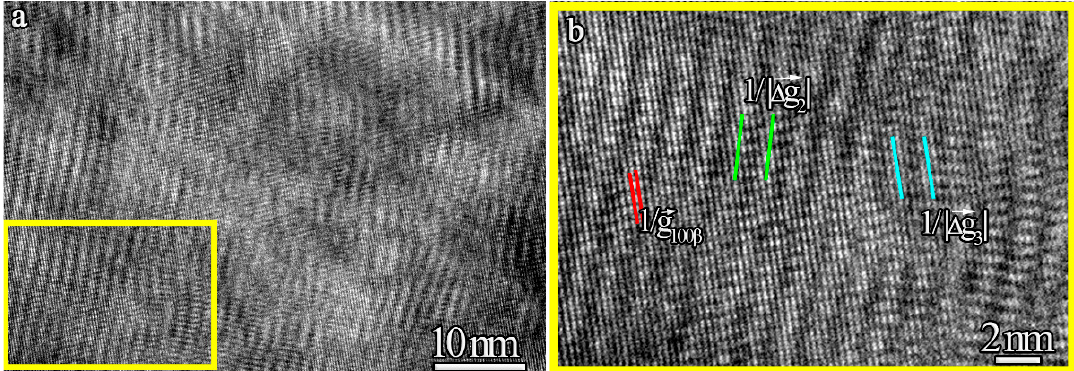
Figure 3. ( a ) HRTEM image of a part of the Cu-Pd36 sample within the block of α -phase subgrains, ( b ) enlarged fragment containing interference bands with a period equal to the β -phase crystal lattice parameter 1 (cid:3627)(cid:3416) , and moiré patterns with the periods (cid:3627)(cid:3416) and (cid:3627)(cid:3416) (2 and 3). (cid:3627)𝑔⃗ (cid:3627) 𝑔(cid:4652)(cid:4652)(cid:4652)(cid:4652)(cid:4652)⃗ (cid:3627) 𝑔(cid:4652)(cid:4652)(cid:4652)(cid:4652)(cid:4652)⃗ (cid:2869)(cid:2868)(cid:2868) (cid:2870) (cid:2871) While there are strictly periodic interference lines (interference of the 000 and 100 β 1 beams) with the period |(cid:3415) ( 𝑔⃗ is the reflection vector from index planes) corre- |𝑔⃗ (cid:2869)(cid:2868)(cid:2868) sponding to the β -phase structure parameters, breaks of moiré patterns with the periods 1 𝑃𝑀1 = 1 (cid:3627)(cid:3416) and 𝑃𝑀2 = (cid:3627)(cid:3416) are observed as a result of double (cid:3627)𝑔⃗ − 𝑔⃗ (cid:3627)𝑔⃗ − 𝑔⃗ (cid:2870)(cid:2868)(cid:2868) (cid:2869)(cid:2869)(cid:2869) (cid:2870)(cid:2870)(cid:2868) (cid:2870)(cid:2870)(cid:2868)